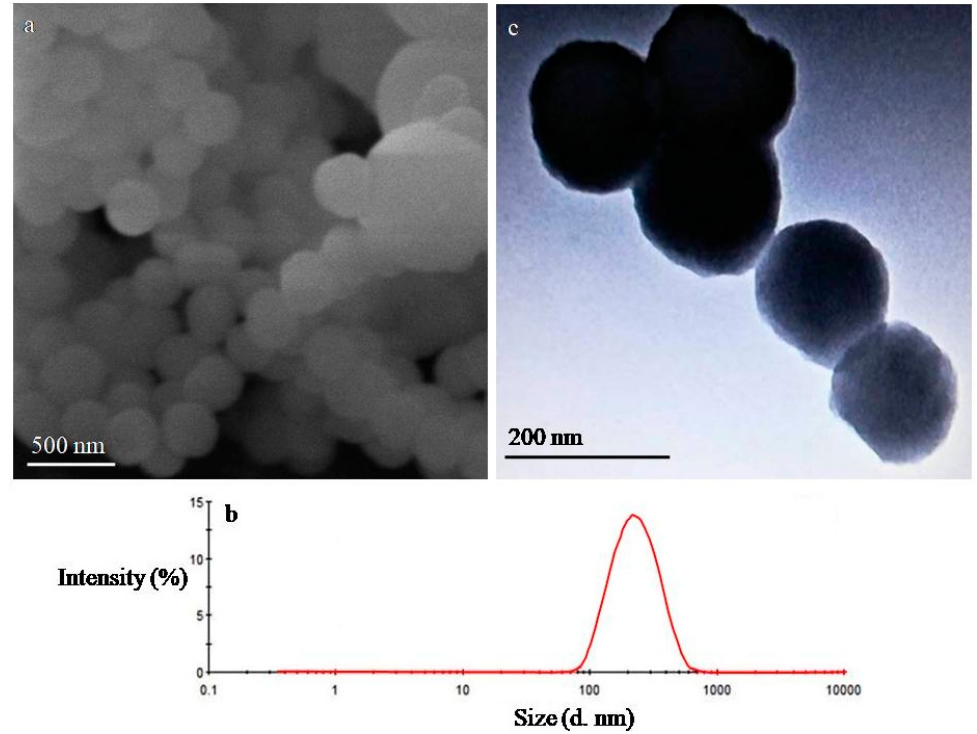
Figure 1. SEM ( a ), particle size distribution ( b ) of VLP-MSN and TEM ( c ) images of MSN respectively.